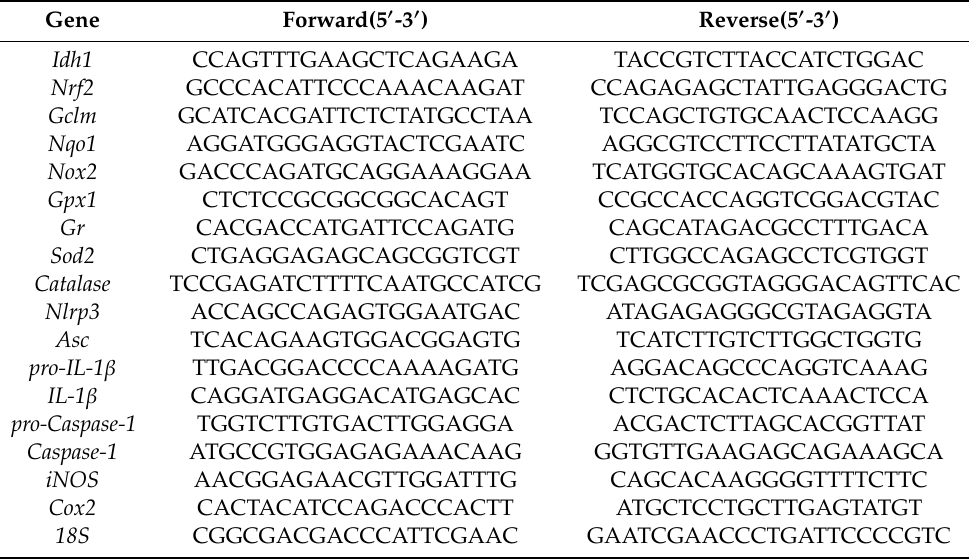
Table 1. List of PCR primers used in this